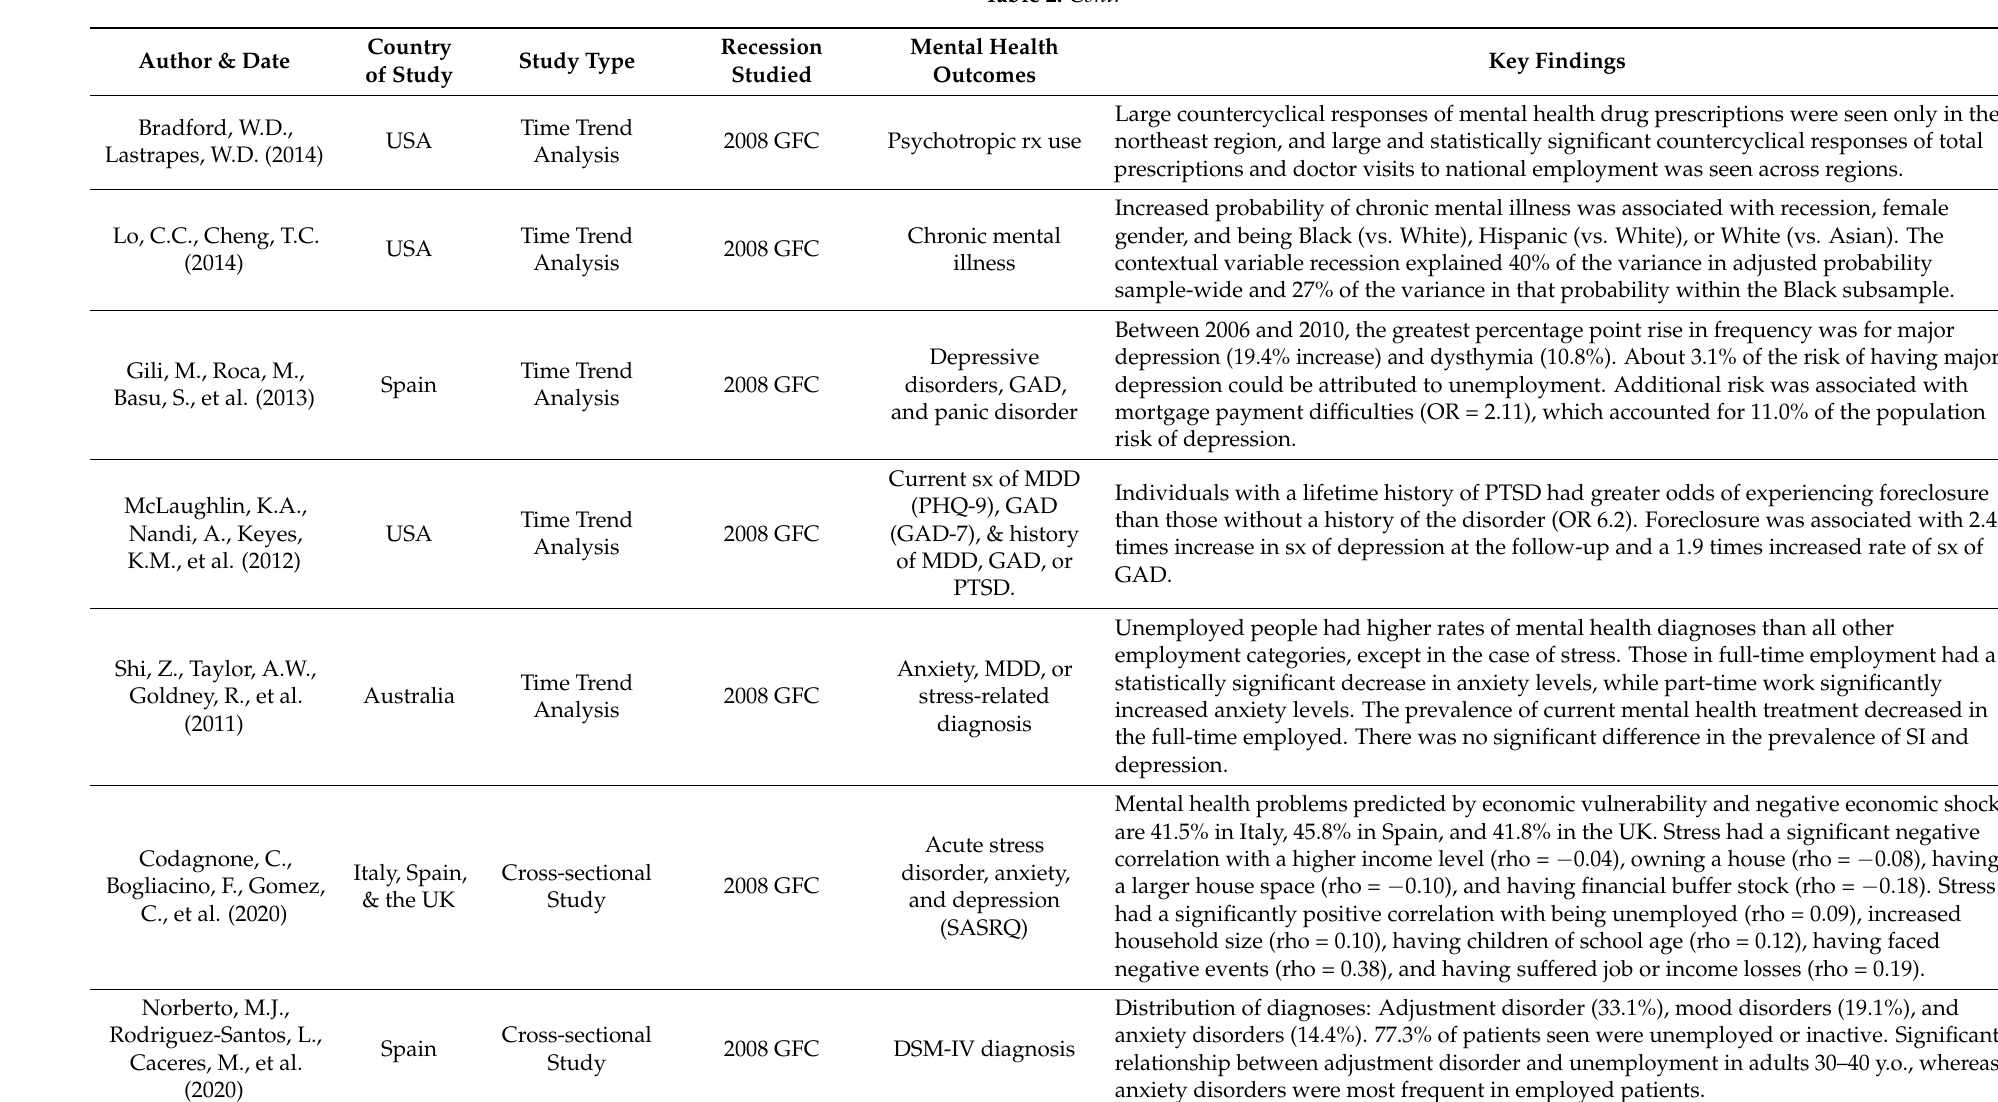
Large countercyclical responses of mental health drug prescriptions were seen only in the northeast region, and large and statistically significant countercyclical responses of total prescriptions and doctor visits to national employment was seen across regions. Increased probability of chronic mental illness was associated with recession, female gender, and being Black (vs. White), Hispanic (vs. White), or White (vs. Asian). The contextual variable recession explained 40% of the variance in adjusted probability sample-wide and 27% of the variance in that probability within the Black subsample. Between 2006 and 2010, the greatest percentage point rise in frequency was for major depression (19.4% increase) and dysthymia (10.8%). About 3.1% of the risk of having major depression could be attributed to unemployment. Additional risk was associated with mortgage payment difficulties (OR = 2.11), which accounted for 11.0% of the population risk of depression. Individuals with a lifetime history of PTSD had greater odds of experiencing foreclosure than those without a history of the disorder (OR 6.2). Foreclosure was associated with 2.4 times increase in sx of depression at the follow-up and a 1.9 times increased rate of sx of GAD. Unemployed people had higher rates of mental health diagnoses than all other employment categories, except in the case of stress. Those in full-time employment had a statistically significant decrease in anxiety levels, while part-time work significantly increased anxiety levels. The prevalence of current mental health treatment decreased in the full-time employed. There was no significant difference in the prevalence of SI and depression. Mental health problems predicted by economic vulnerability and negative economic